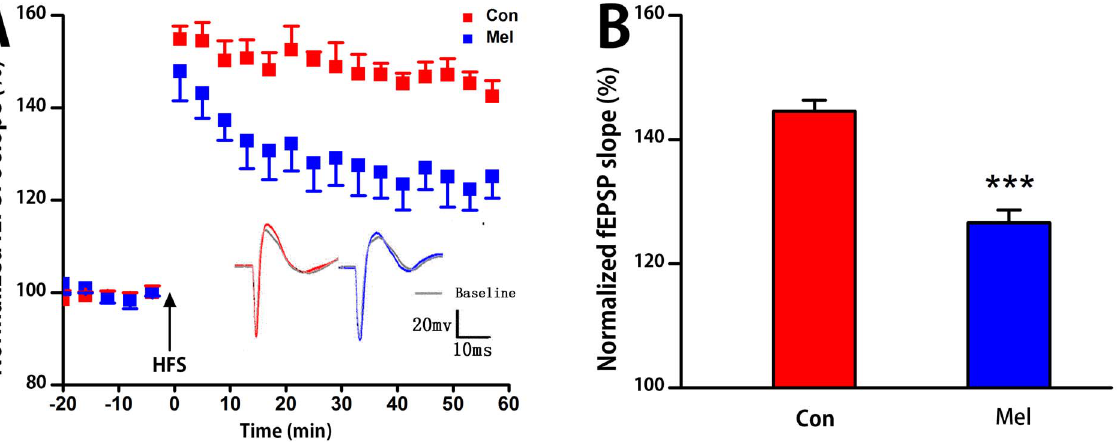
Figure 6. The LTP test in CA3-CA1 pathway. A. Low-frequency stimulation of Schaffer collaterals region for 20 min as the base line. The fEPSPs slope is plotted as a percentage change against the baseline before high-frequency titanic stimulation (HFS) indicated by arrows. Inset: reprehensive fEPSPs in Con group (left) and Mel group (right). B. Statistical results of fEPSPs in both Con group and Mel group. ***P , 0.001 for comparison between Con group and Mel